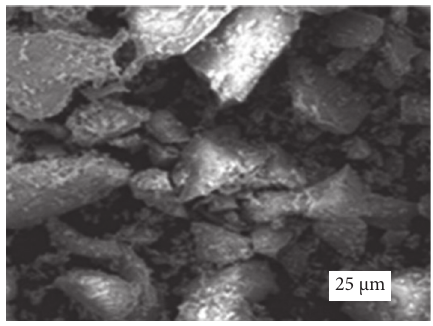
Figure 3: Morphology of M-sand.